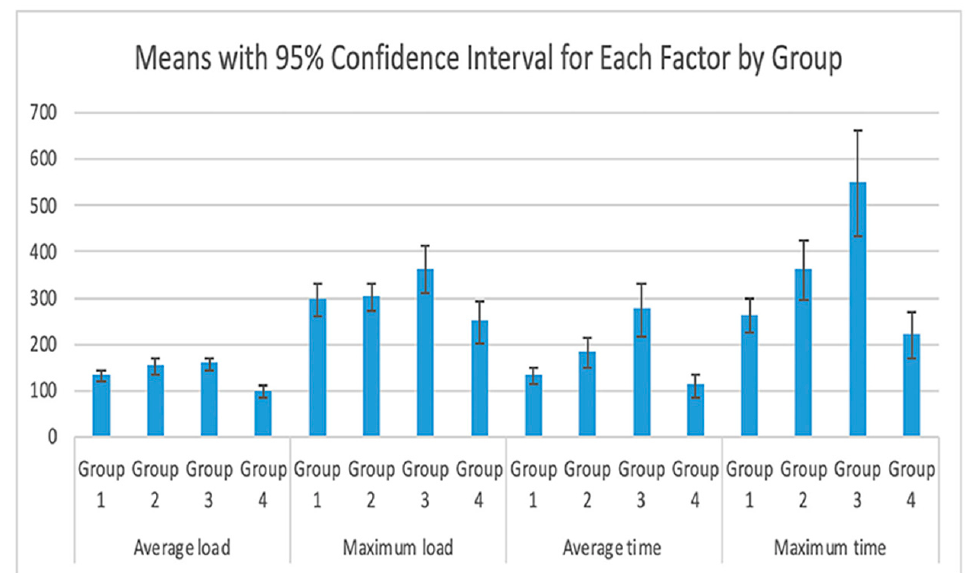
Figure 8. Comparison between fabrication materials with the control group. The mean difference values are shown in Table 2. The load values necessary to create failure in Group 4 (CMZPCs) were lower when compared with those of Group 3 (CPTPCs), Group 2 (CMTPCs), and Group 1 (CCNPPCs); furthermore, all groups showed different distributions at the time of failure and were statistically significantly higher for Group 3 (CPTPCs) and Group 2 (CMTPCs) ( p < 0.05). Group 3 (CPTPCs) and Group 1 (CCNPPC group) required loads of 361.5 N and 295.9 N, respectively, to fail, and the difference was statistically significant ( p < 0.05). When considering Group 4 (CMZPC group) and Group 3 (CPTPCs), they required loads of 361.5 N and 248.1 N, respectively, and this difference was statistically significant ( p < 0.05). The differences in the averages of maximum time and average total time between Group 3 (CPTPCs), Group 2 (CMTPCs), Group 1 (CC- NPPCs), and Group 4 (CMZPCs) were significant ( p < 0.05), with higher values recorded for Group 3 (CPTPCs) in comparison with all other groups (Figure 8).